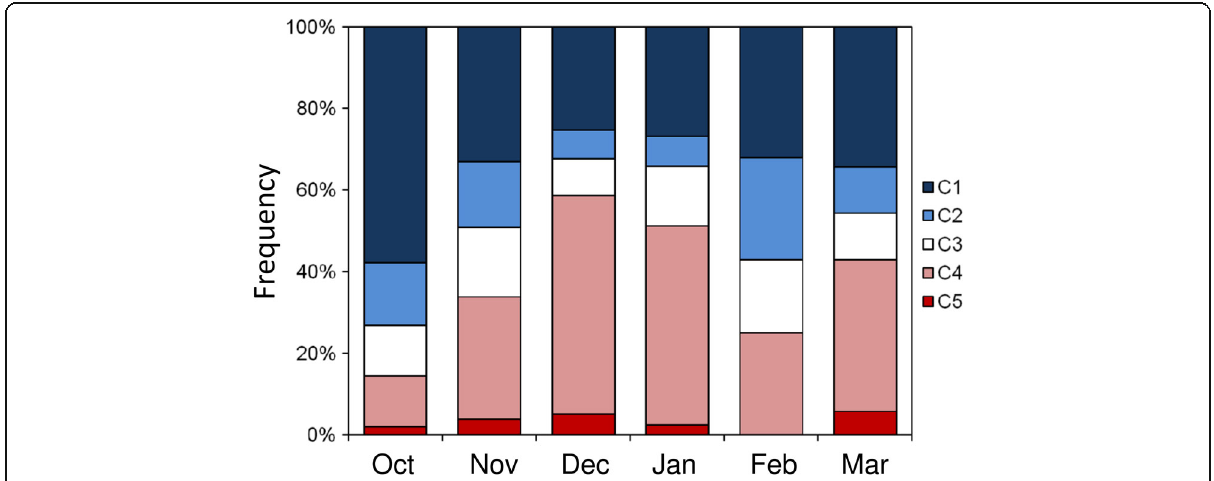
Fig. 6 Seasonal variation of lightning occurrence for five clusters ( C1 , C2 , C3 , C4 , C5